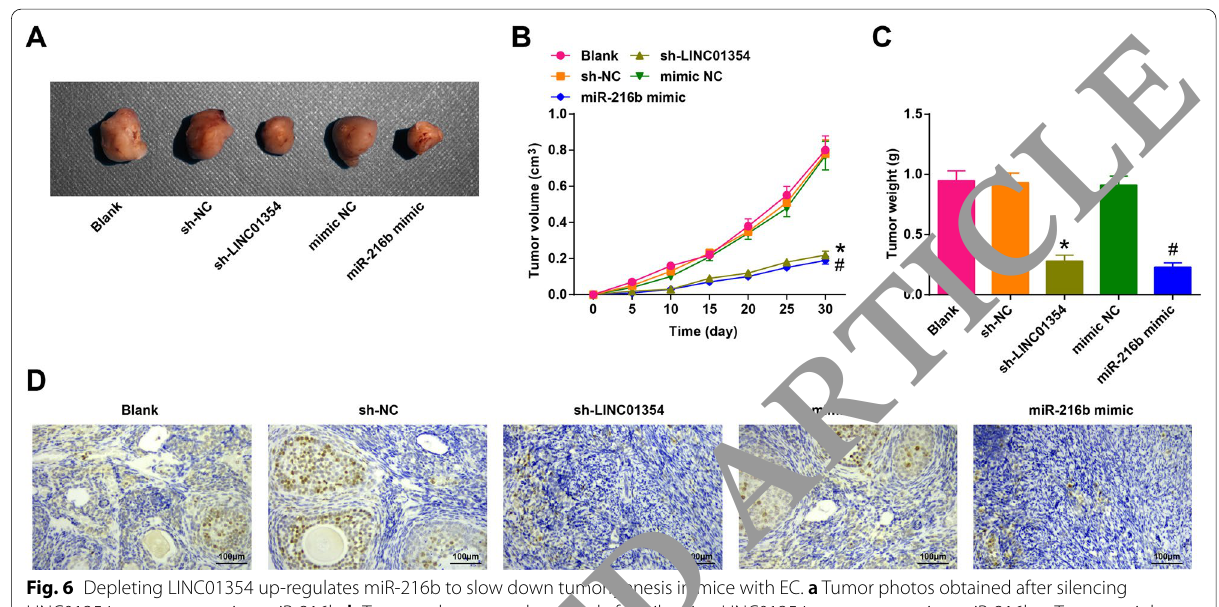
Fig. 6 Depleting LINC01354 up-regulates miR-216b to slow down tumorigenesis in mice with EC. a Tumor photos obtained after silencing LINC01354 or overexpressing miR-216b; b Tumor volume was decreased after silencing LINC01354 or overexpressing miR-216b; c Tumor weight was suppressed after silencing LINC01354 or overexpressing miR-216b; d KRAS expression was reduced after silencing LINC01354 or overexpressing miR-216b (IHC). The data were expressed as